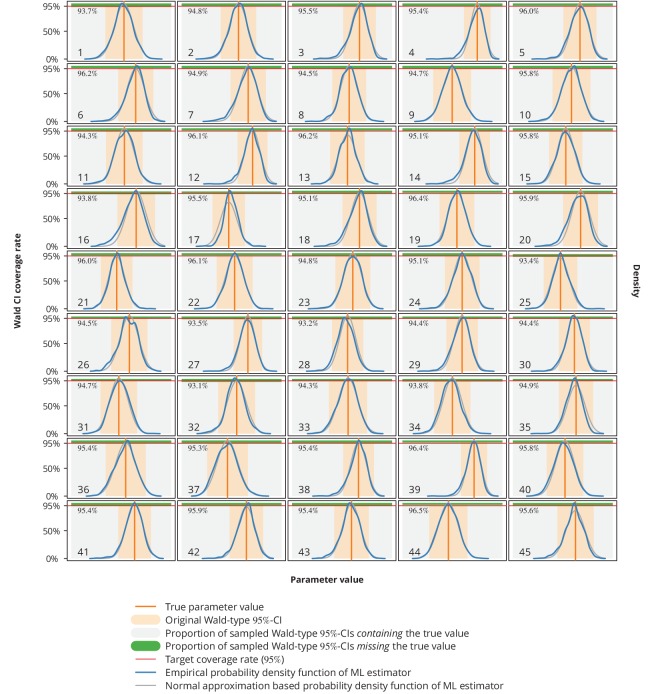
Empirical distribution of maximum likelihood (ML) estimator and the Wald-type confidence intervals (CI) coverage rates.Each plot represents a single parameter from a single model (see Appendix 1—table 1 for the parameters overview including their values), where the number in the lower left corner denotes the parameter’s consecutive parameter number. The light gray-shaded area represents the proportion of the Wald-type 95%-CIs from the parametric bootstrap simulations which contained the true value (depicted by the vertical orange line), while the green-shaded area corresponds to those CIs from the simulations that missed the true value. The numbers in the upper left corners are the coverage rates from the parametric bootstrap. The original Wald 95%-CIs used in our study are displayed with the light orange-area. The dark blue and gray lines show the empirical distribution of ML estimators from the parametric bootstrap samples and the normal approximation based probability density function, respectively. The horizontal red lines depict the target coverage rate of 95%.